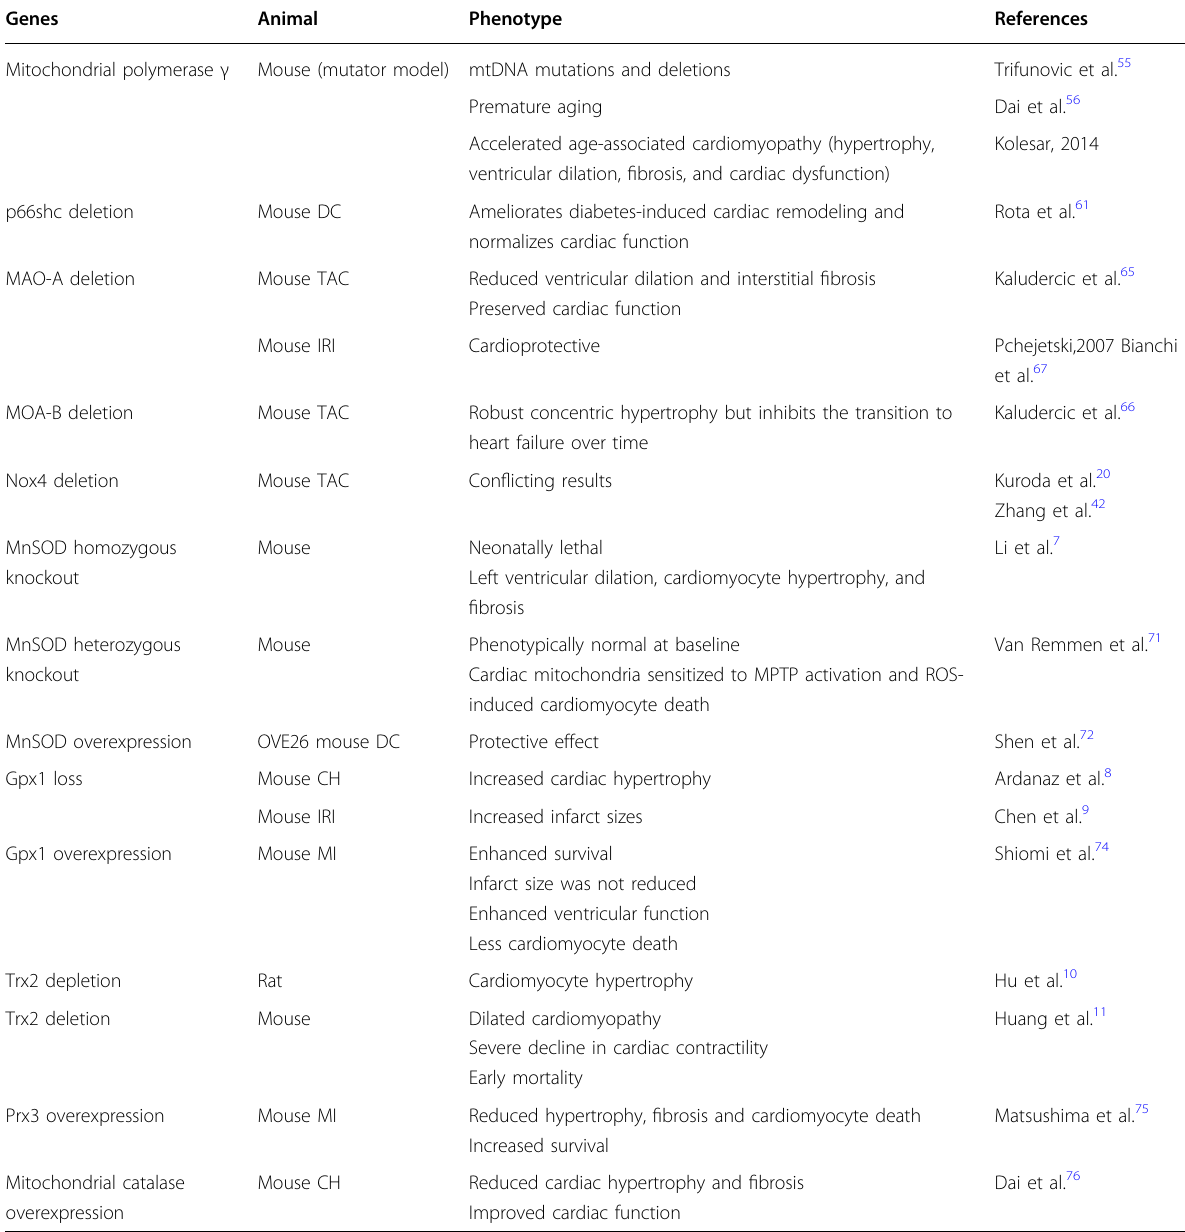
Table 1 Summary of animal models of mitochondrial ROS and cardiac disease pathogenesis. Genes